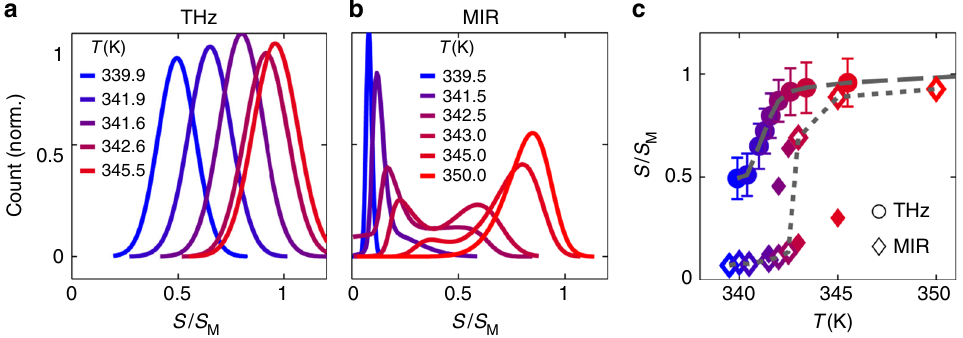
Fig. 3 Histogram analysis of the VO 2 SNOM images at THz and MIR frequencies. a Pixel intensity histograms of selected THz images shown in Fig. 2. The signal level S is shown normalized to that obtained on gold ( S M ). b Same, for MIR images. c Peak signal level as a function of temperature in the THz (circles) and MIR (diamonds) extracted from single or bi-modal Gaussian fi ts to the histograms. The error bars (s.d.) in the THz are derived from parameter estimation in a non-linear least-squares fi t, and are limited by the random noise in the THz near- fi eld signal measurement. The MIR error bars are smaller than the symbols and so are omitted. In the MIR case, there are two peaks at intermediate temperatures due to the bimodal nature of the pixel intensity distribution. The maximum peak at intermediate temperatures is an open diamond, while the smaller peak is a fi lled diamond (Supplementary Note 1). The dashed (THz) and dotted (MIR) lines are guides to the